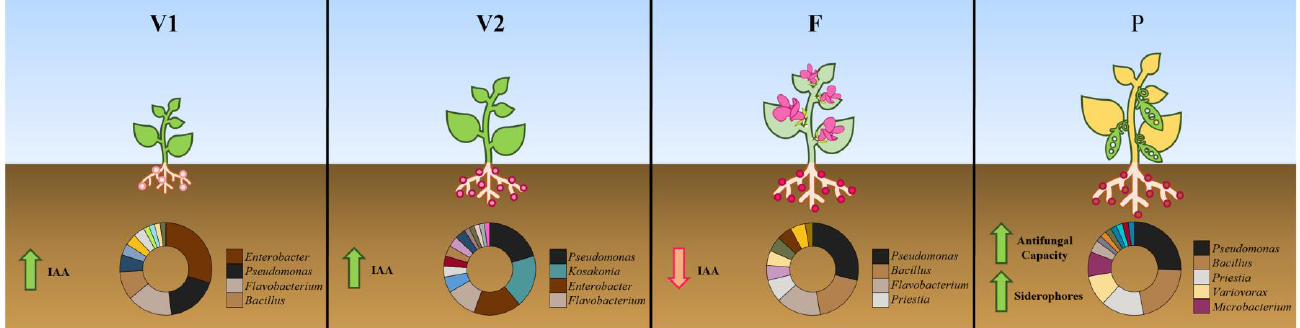
Figure 7. Overview of bacterial genera distribution and major impacts of bacterial diversity at different stages of Phaseolus vulgaris L. development. V1: beginning of vegetative growth (7 days after emergence), V2: end of vegetative growth (21 days after emergence), F: flowering stage (35 days after emergence), P: P-pod stage (49 days after emergence). The main plant growth-promoting abilities are as follows: IAA, production of 3-indole acetic acid, siderophore production, and antifungal activity towards F. oxysporum (green arrows indicate high ability; red arrows pointing down represent low ability). Bacterial diversity at the genus level is expressed in a circular chart, with the name of the most